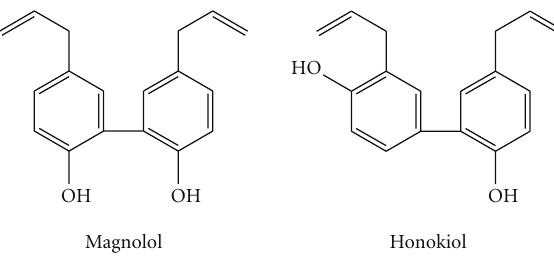
Figure 1: Structures of magnolol and